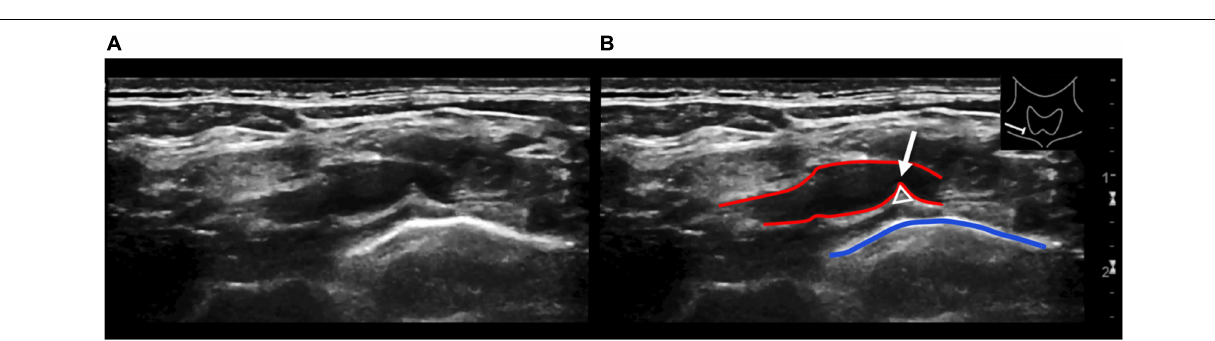
FIGURE 4 | Longitudinal ultrasound view of the right subclavian artery at the level of the pleurocupular region (A) . Illustration of the same ultrasound image (B) . The red lines show the subclavian artery with indentation (white arrow) through the pleurocupular ligament (white triangle). The blue line identifies the pleural apex. Caution should be given to a depressed or angulated subclavian artery without associated flow reduction. This is a frequently seen and unspecific finding and therefore should not be